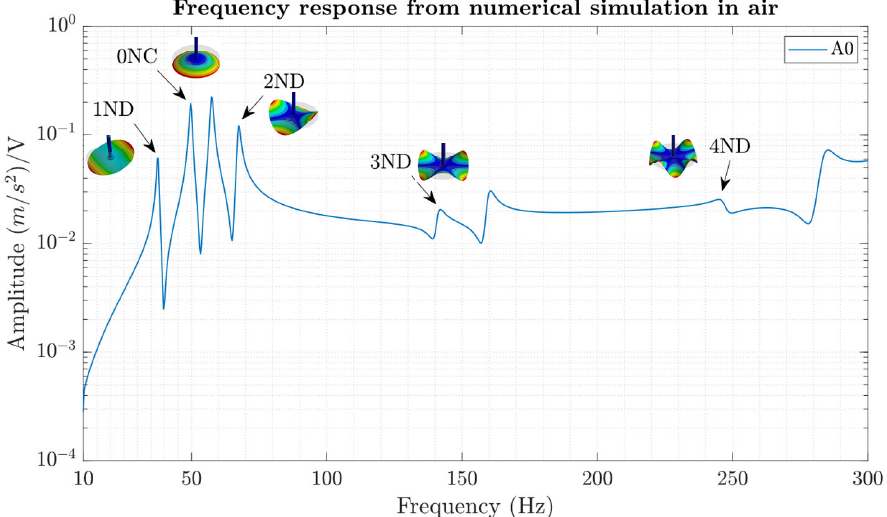
Figure 9. Numerical frequency response obtained from a harmonic analysis when the disk was not rotating in air.